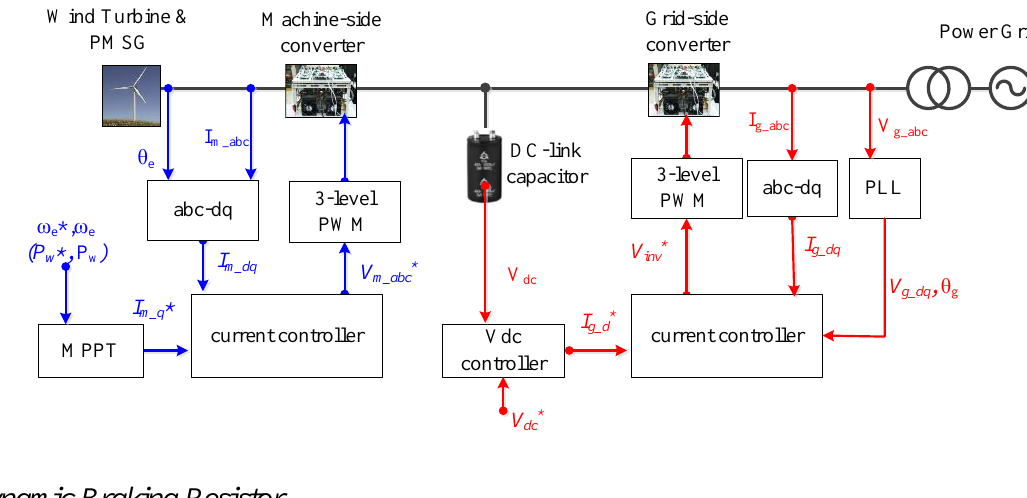
Figure 1. Configuration of a wind power system and control block diagram.